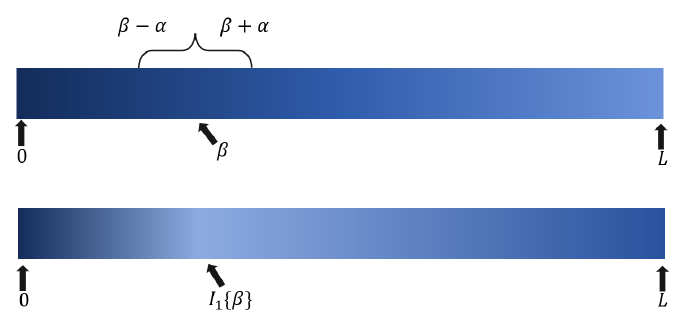
Figure 7. The improvement of the contrast image in the bottom row is demonstrated via luminance transformation using the sigmoid function